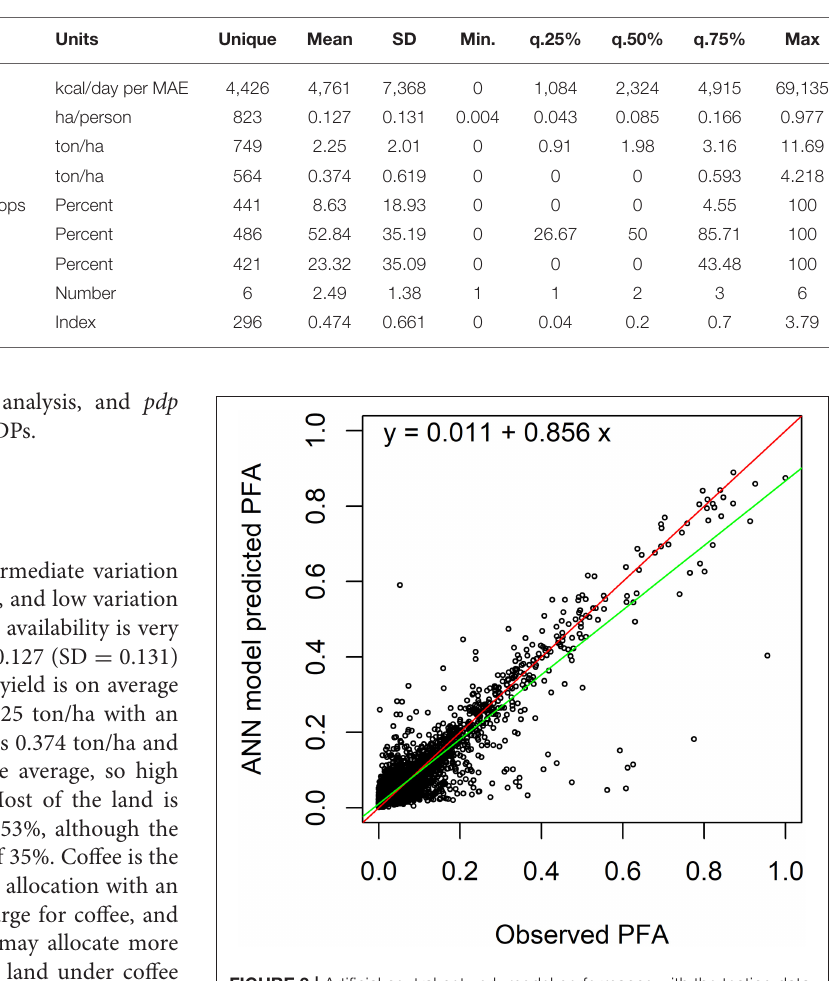
FIGURE 3 | Artificial neutral network model performance with the testing data set. A red line represents the 1:1 relationship, whereas the green line represents the linear regression of observed vs. predicted